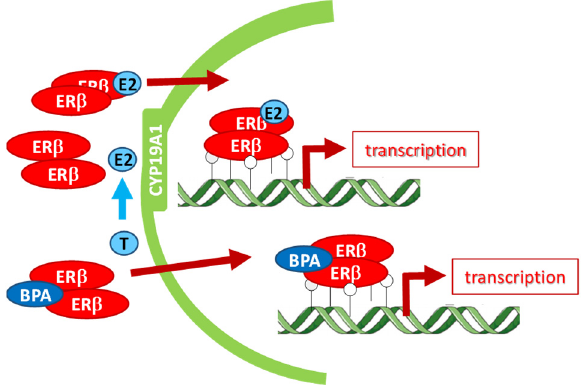
Figure 9. Schematic explaining mechanism of action of ERbeta and CYP19A1 interaction at the acrosome. T, testosterone; E2, estradiol. CYP19A1catalyzes conversion of T to E2. E2 binds to ERbeta (ER β ). ERbeta-E2 enters the nucleus and regulates expression of genes involved in cell survival and apoptosis.